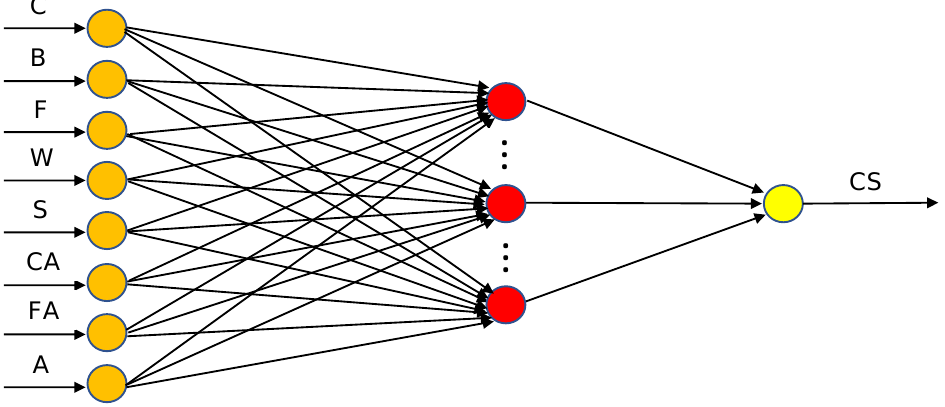
Figure 3. The network architecture used in the ELM and RELM